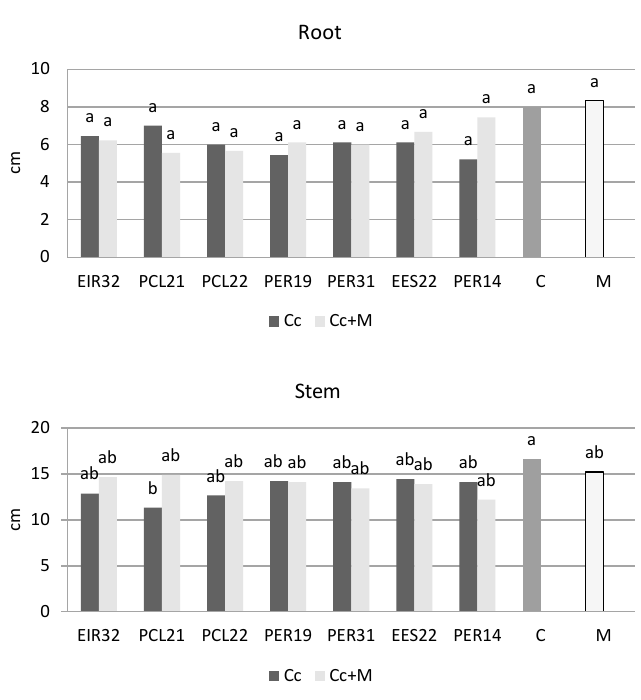
Fig. 2 Size of tomato roots and stems of seedlings inoculated with the pathogenic fungus (Cc), seedlings with the mycorrhiza and pathogenic fungus (Cc+M), control combinations (M, C); values marked with the same letters for the size of plants do not differ significantly at p ≤ 0.05 (Tukey’s